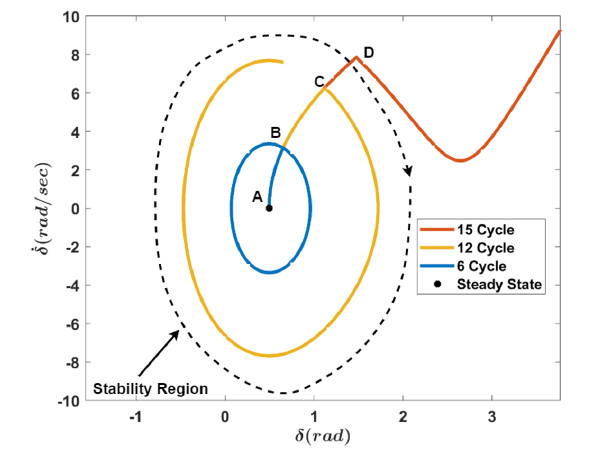
Figure 3. Phase-plane plot of